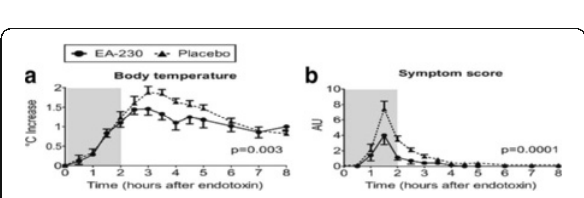
Fig. 51 (abstract A132). Body temperature (A) and symptom score (B) during endotoxemia. Data are represented as means with SEM of n = 7 in the EA-230 180 mg/kg group and n = 12 in the placebo group. Gray box indicates the period in which the active group